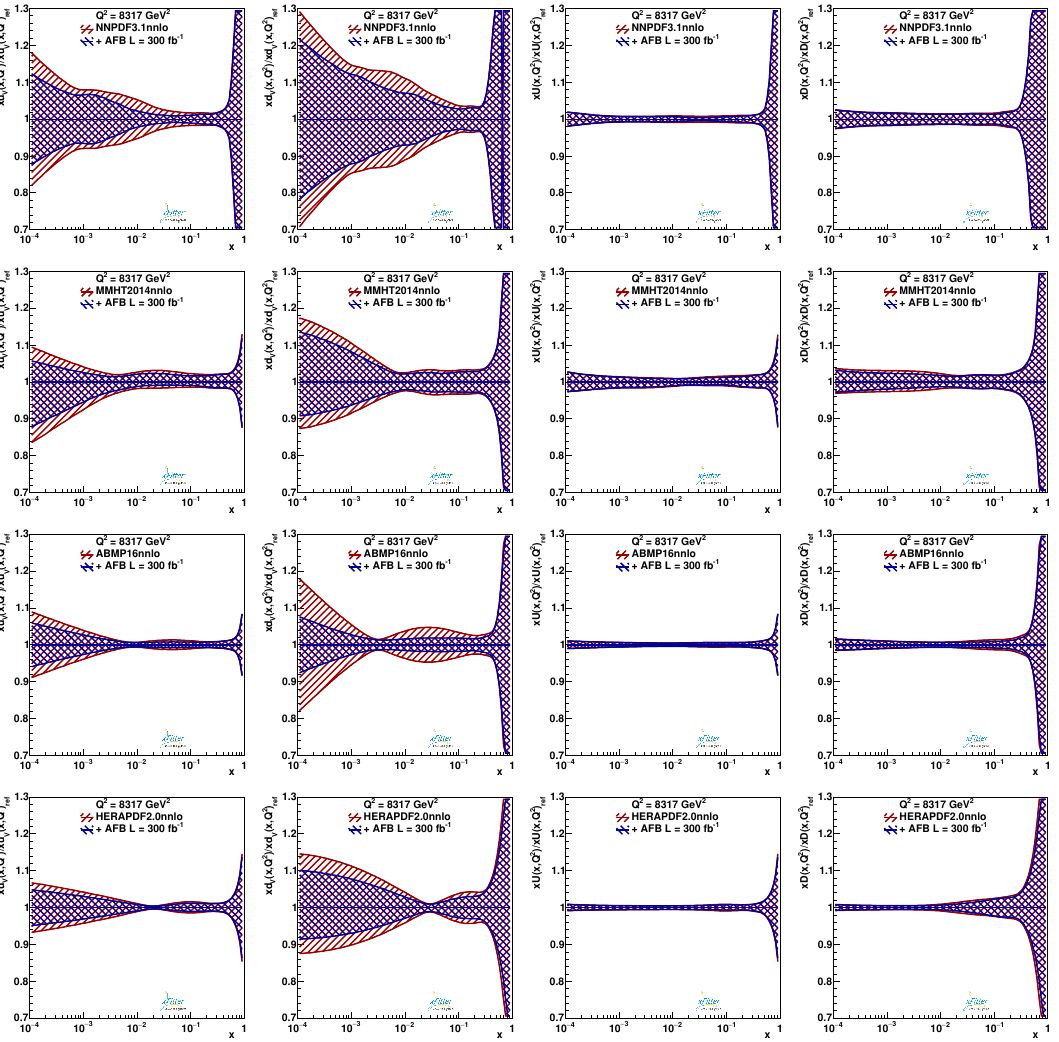
Figure 3 . Original (red) and pro(cid:12)led (blue) distributions for the normalised distribution of the ratios of (left to right) u -valence, d -valence, u -sea and d -sea quarks. The pro(cid:12)led curves are obtained using A (cid:3) pseudodata corresponding to an integrated luminosity of 300 fb (cid:0) 1 . Distributions are FB shown for the PDF sets (rows top to bottom) NNPDF3.1nnlo, MMHT2014nnlo, ABMP16nnlo and